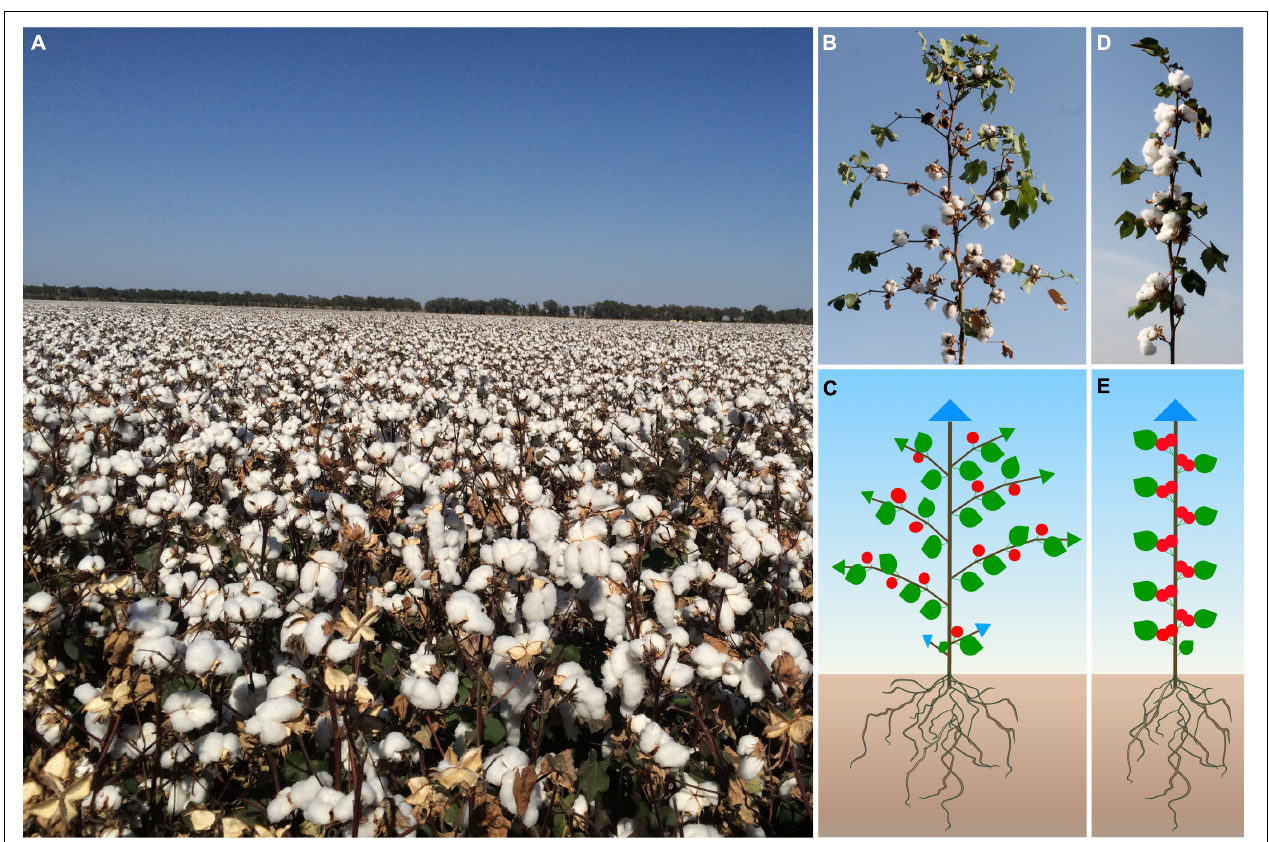
FIGURE 1 | The cultivation feature and plant architecture of cotton. (A) The planting pattern of short-dense-early cotton in Xinjiang Uygur Autonomous Region, China. Phenotype of normal fruit branch upland cotton (B) and its schematic diagram (C) . Phenotype of short fruit branch upland cotton (D) and its schematic diagram (E) . Blue triangles indicate monopodial shoot apical meristem; green triangles represent sympodial shoot meristem; red balls represent determinate floral buds; green peach-like shapes indicate